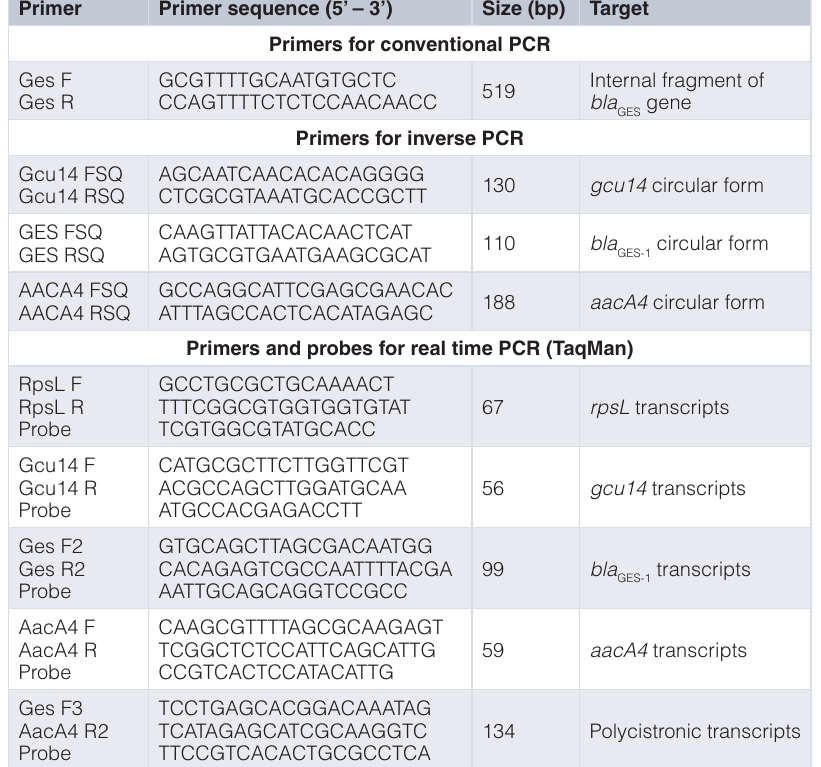
(30 μM each); 100 ng of template DNA; 0.3 μL of Platinum Taq